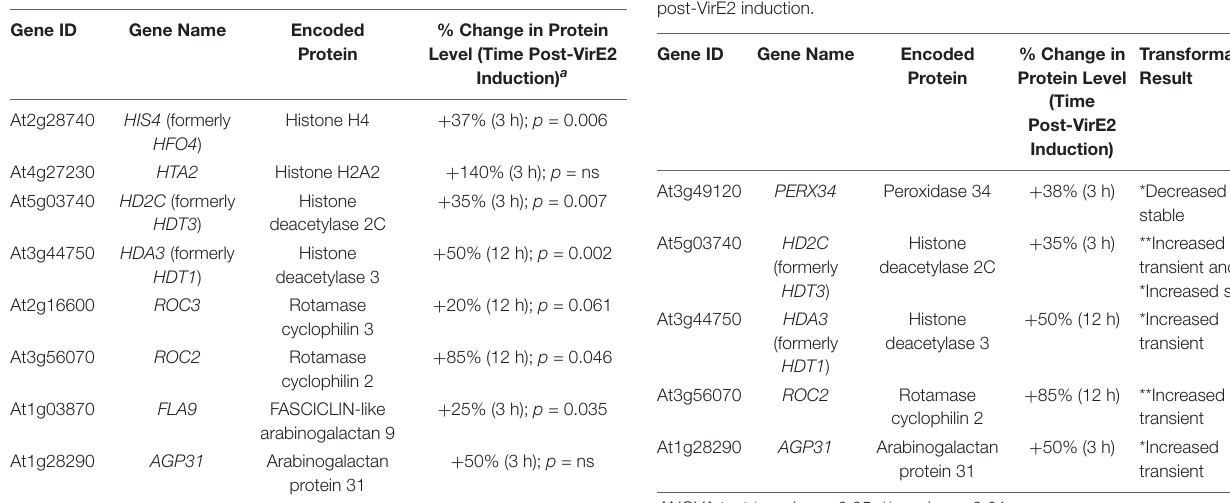
TABLE 4 | Proteins previously identified as important for transformation show increased abundance in the presence of VirE2.